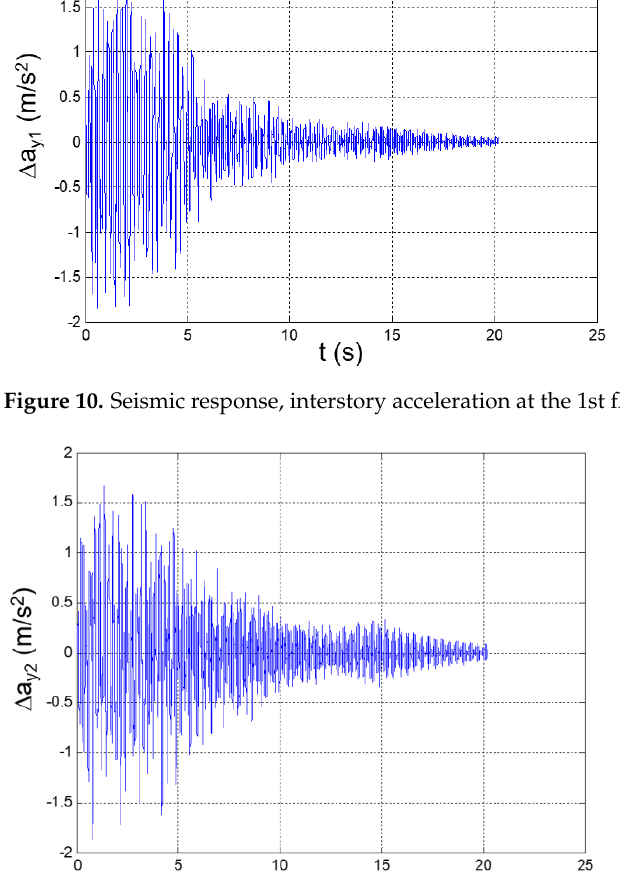
Figure 9. Seismic response, 5th-floor acceleration (Node 49) with respect to the ground.